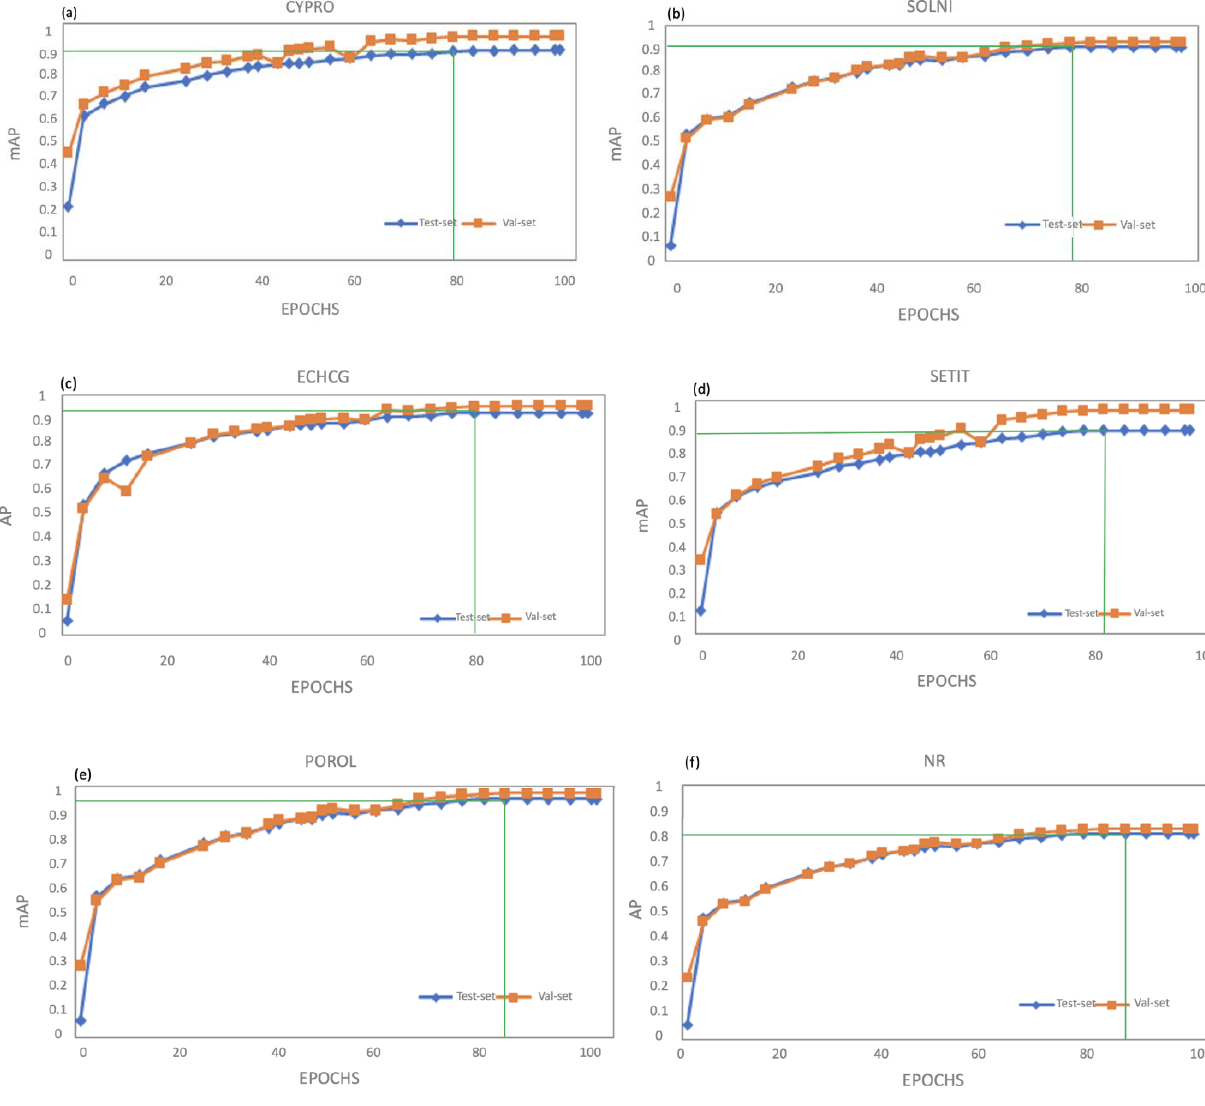
Figure 5. Learning curves of the weed species over the validation set (rhombus data markers) and test set (square data markers). ( a ) Cyperus rotundus L. (CYPRO), ( b ) Solanum nigrum L. (SOLNI), ( c ) Echinochloa crus galli L. (ECHCG), ( d ) Setaria verticillata L. (SETVE), ( e ) Portulaca oleracea L. (POROL), ( f ) Not recognized. Table 3. Performance detection of the monocotyledonous and dicotyledonous weeds by mAP metric between each